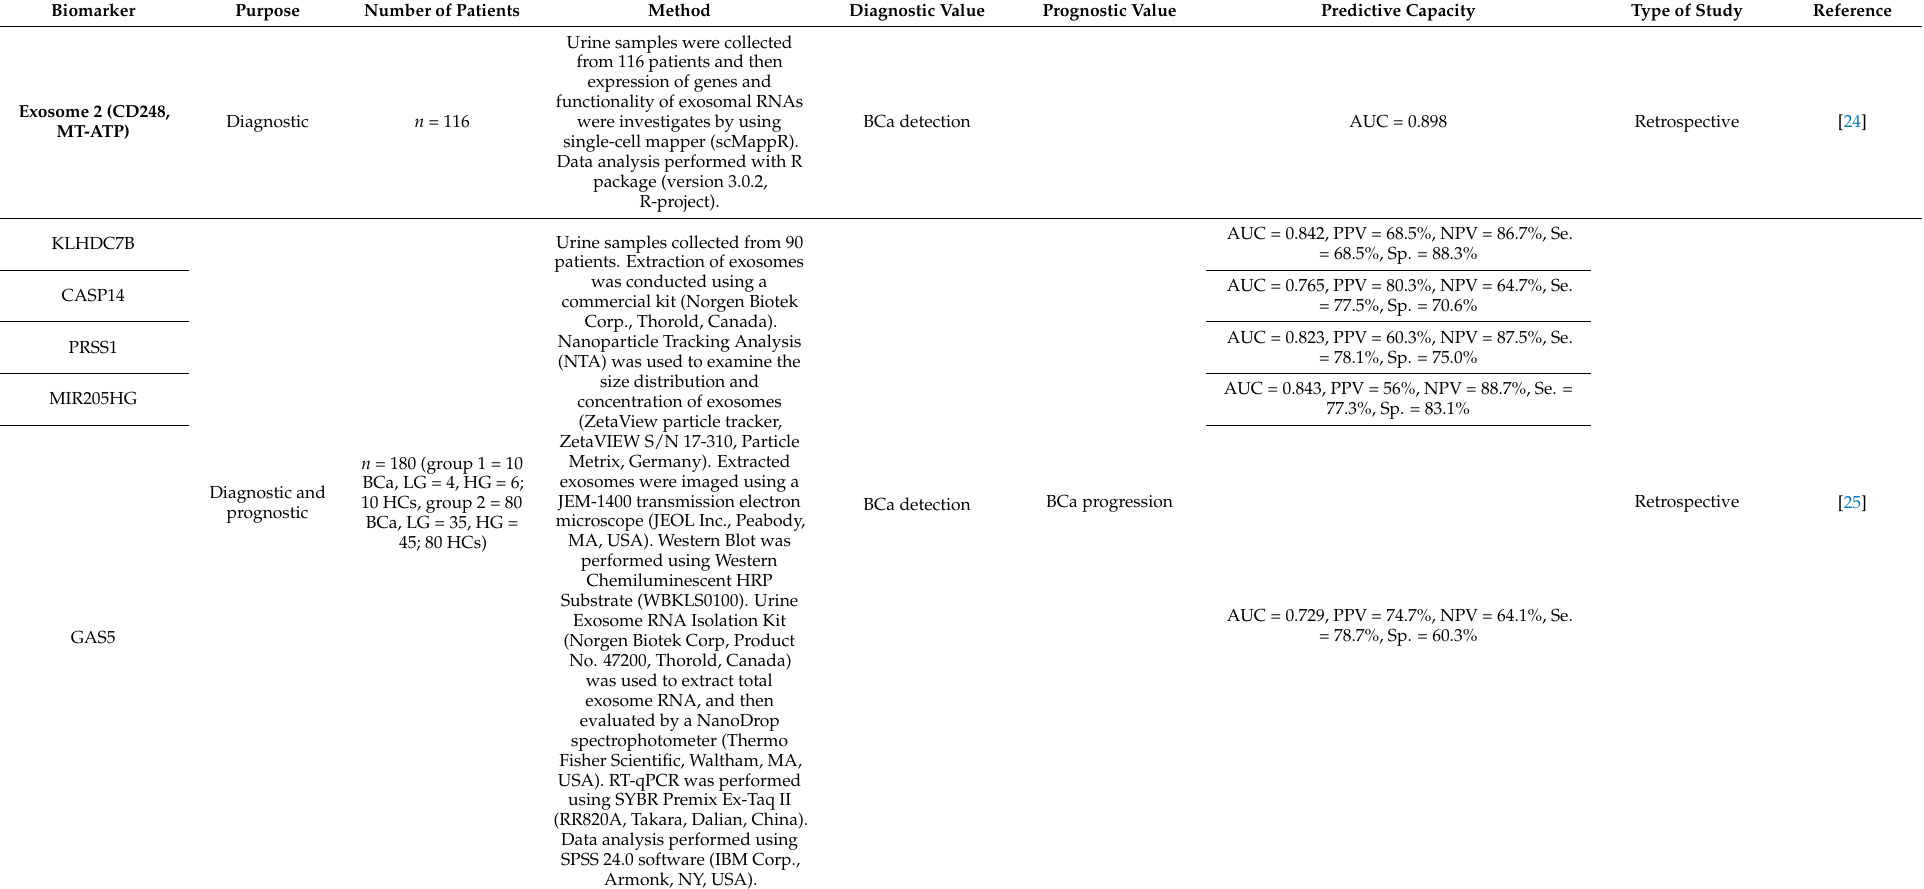
Table 2. Table presenting data for